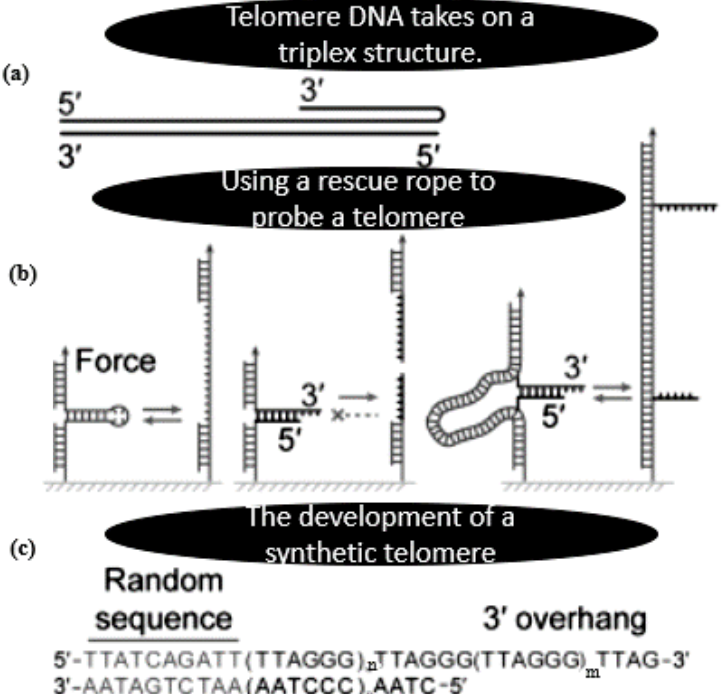
Figure 4. A rescue rope approach for investigating an artificial telomere. ( a ) The DNA in telomeres adopts a triplex shape. The G-rich and C-rich strands are denoted by red and black, respectively. ( b ) Using a rescue rope to probe a telomere with a free end. Structures having a closed end can be repeatedly manipulated by conventional mechanical pulling experiments, such as a DNA hairpin (left). A construction with an open end cannot rotate mechanically in circles before relaxing (middle). A rescue-rope technique supported by dsDNA enables recurrent operations on a structure with a free end, such as a telomere (right). ( c ). Designing a synthetic telomere. The identical configuration of the artificial telomere in melting/reannealing rings is guaranteed by a random sequence at the blunt upstream end. In a duplex and a three overhang, the TTAGGG motif count might change. With n = 5 and m = 2.